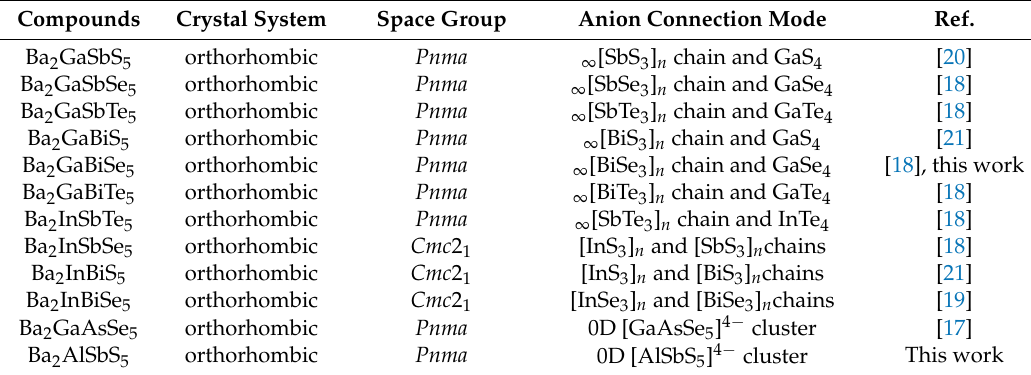
Table 2. Structural comparison among the series of Ba 2 M III M III ’Q 5 (M III = Al, Ga, In; M III ’ = As, Sb, or Bi; Q = S, Se, Te)